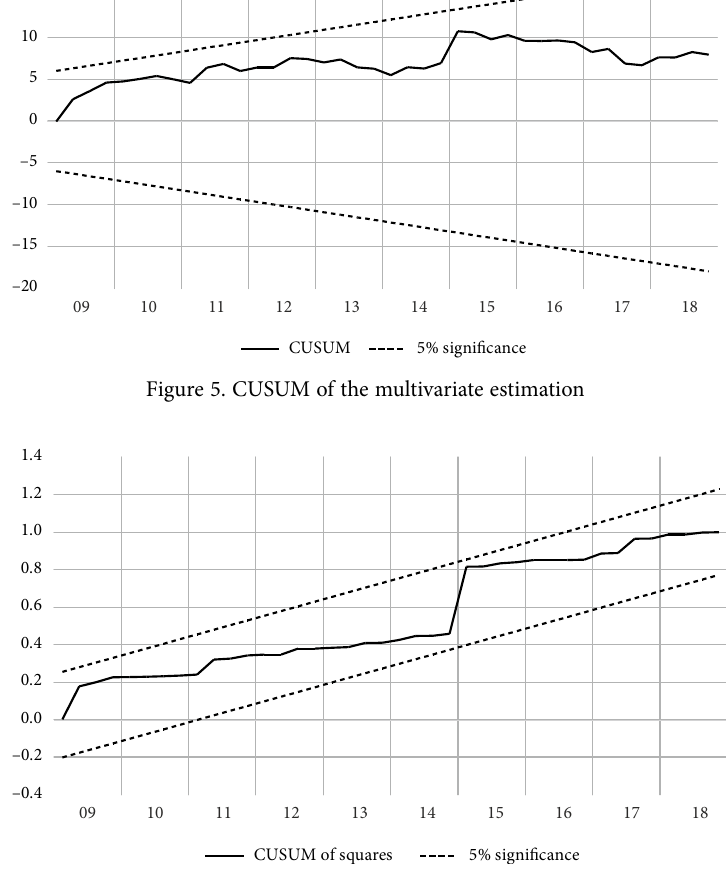
Figure 6. CUSUM of squares of the multivariate